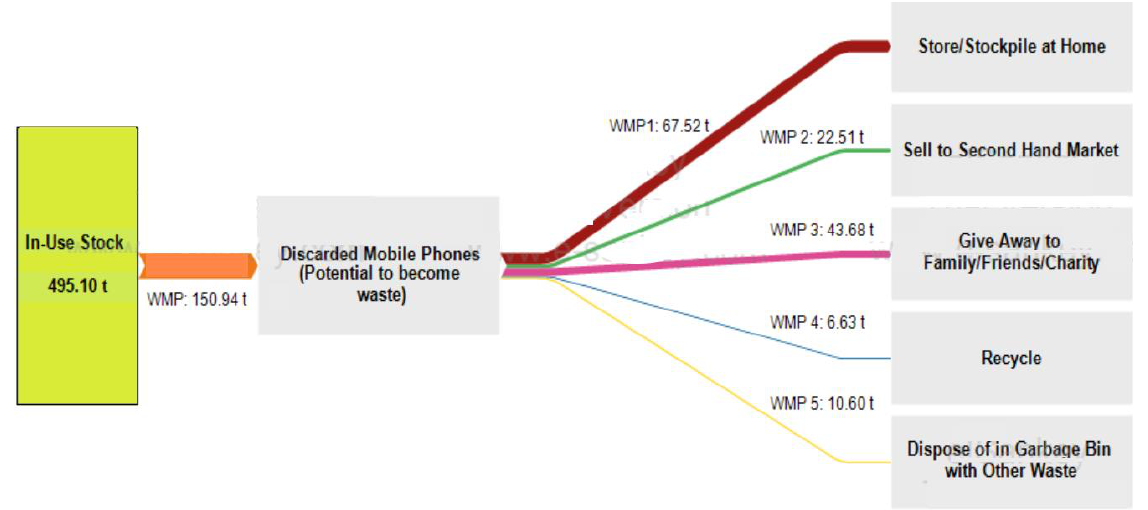
Figure 19. Obsolete/Discarded Mobile Phones Possible Pathways.